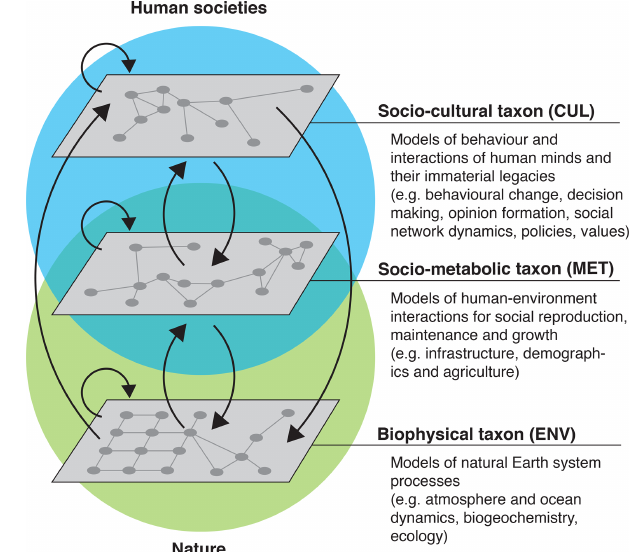
Figure 1. Proposed taxonomy of subsystems in World–Earth sys- tems models. The blue and green overlapping discs represent the current discipline-based domains in which the subsystems and pro- cesses of nature, human societies and their interactions are mod- elled. Our scheme structures this continuum into three taxa (light grey layers) for model subsystems (dark grey discs): (i) a biophys- ical taxon (ENV), (ii) a socio-metabolic taxon (MET) and a socio- cultural taxon (CUL). Links within and between these modelled subsystems (shown as black arrows in the figure) can further be classified using a 3 × 3 taxonomy of interactions (Fig. 2, Sect.